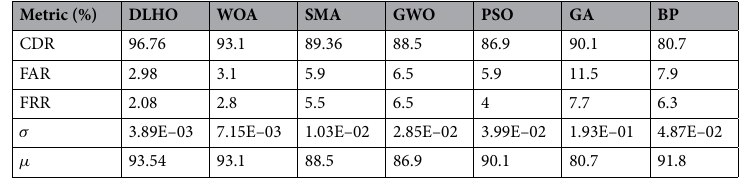
Table 9. Comparison of different algorithms on MIAS database in terms of different metrics.